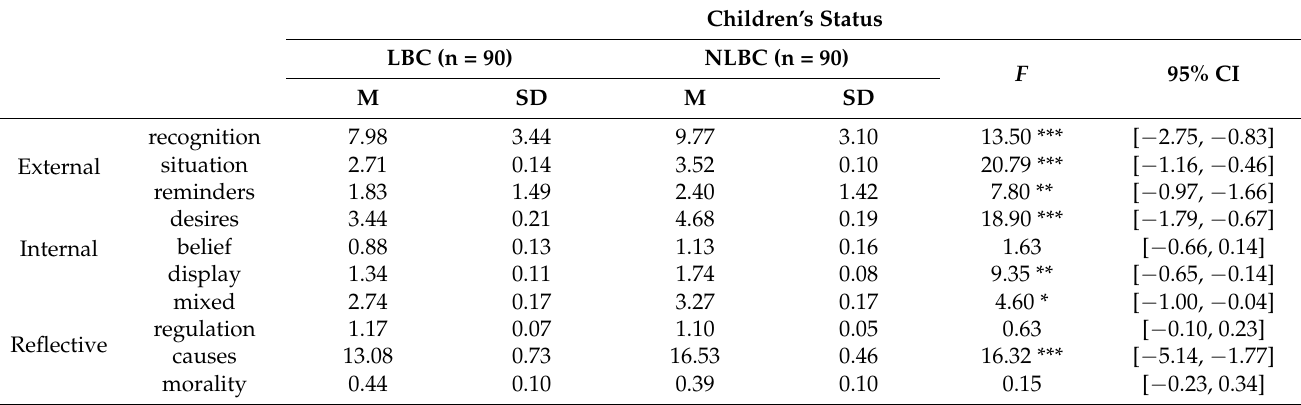
Table 1. Comparison of EU between two groups of